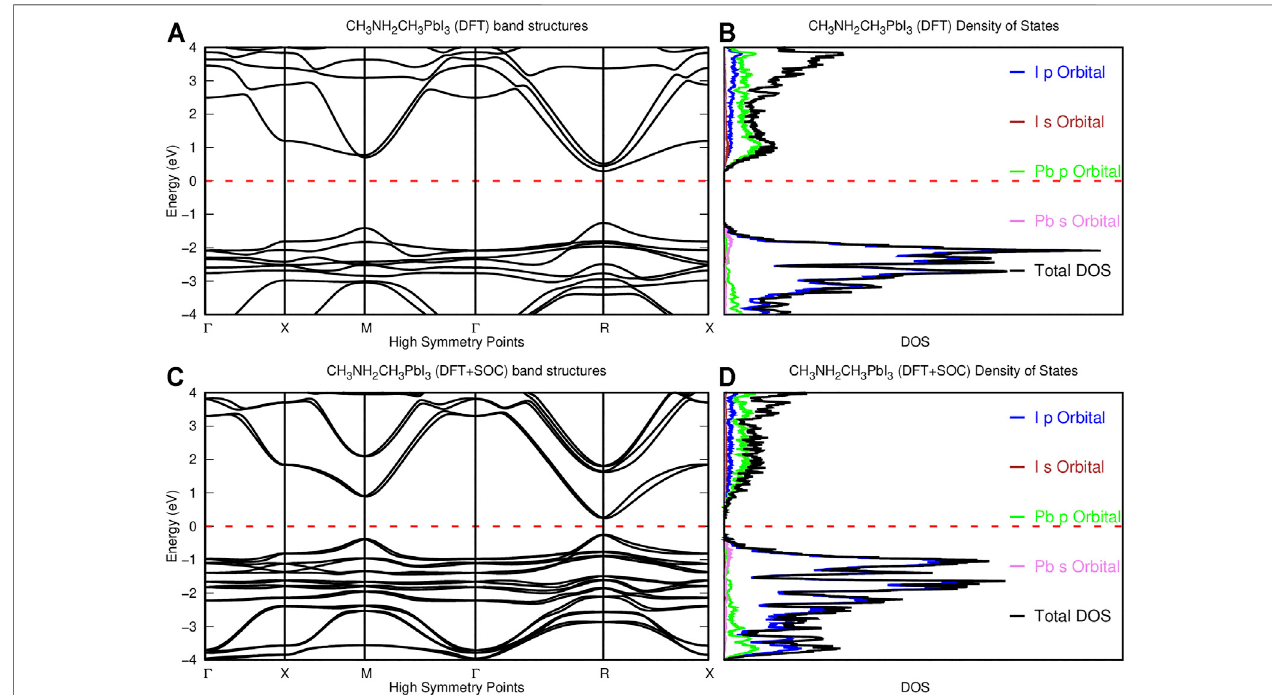
FIGURE 2 | DFT band structure and density of states of pseudo-cubic CH 3 NH 2 CH 3 PbI 3 . (A) DFT band structure of CH 3 NH 2 CH 3 PbI 3 . (B) DFT density of states of CH 3 NH 2 CH 3 PbI 3 . (C) DFT + SOC band structure of CH 3 NH 2 CH 3 PbI 3 . (D) DFT + SOC density of states of (CH 3 )NH 2 CH 3 PbI 3 .